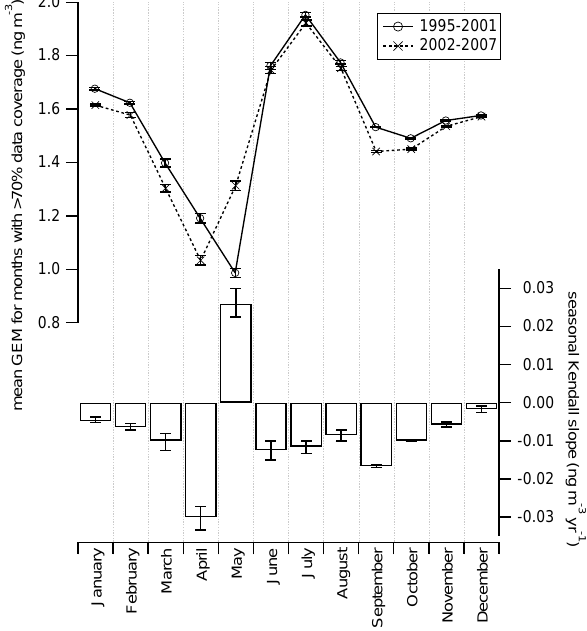
Fig. 1. Seasonal profiles of gaseous elemental mercury concentra- tions at Alert for 1995–2001 and 2002–2007 (top); change in con- centration with time calculated for each month by Sen’s estimator of slope